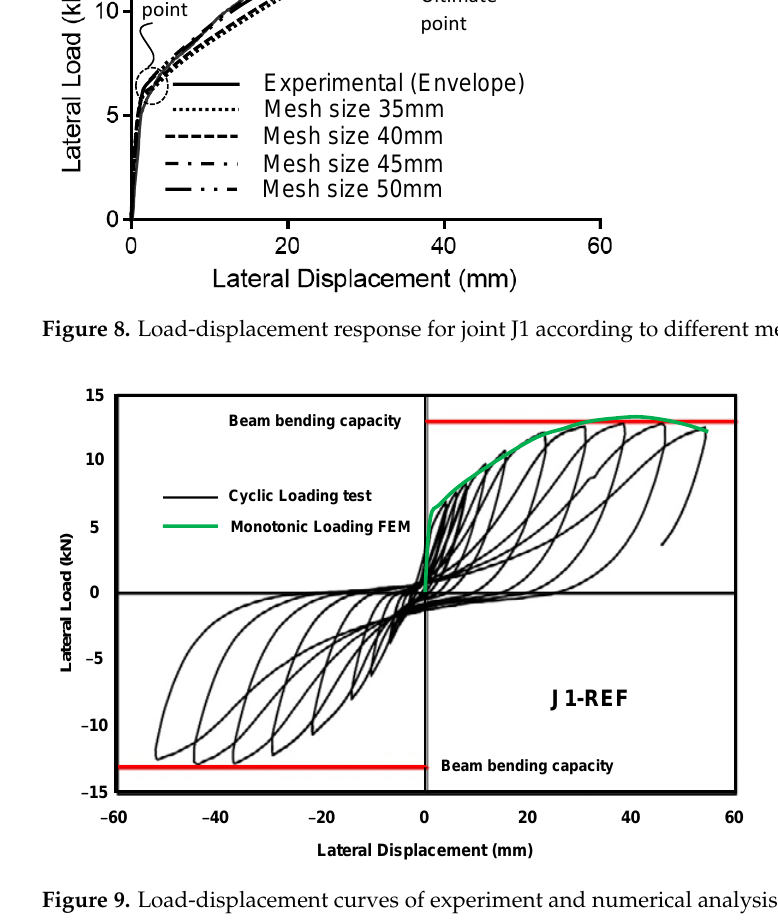
1.03 Figure 11. Joint J1 load-displacement response based on dilation angle variation. 4.2. Sub-Standard Joints Figure 12 presents the response of the two sub-standard joints J2 and J4. The joints’ numerical ultimate load capacity is 10.5 and 5.22 kN, respectively. A reduction of 28% from the standard joint capacity took place in the case of joint J2 and the reduction is mag- nified to reach 60.5% for joint J4. As the concrete dilation angle represents the material volume change accompanied with the resulting shear deformation, its value should be in